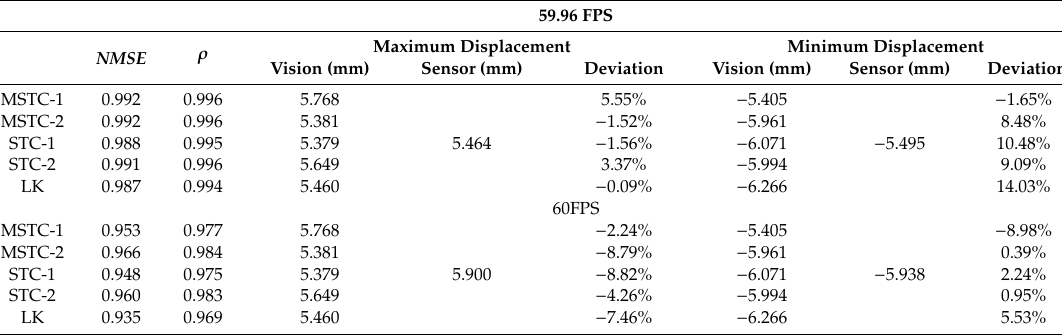
Figure 22. Displacement time history and local amplification in Scenario IV (60 FPS). Table 3. Evaluation of displacement results without interference